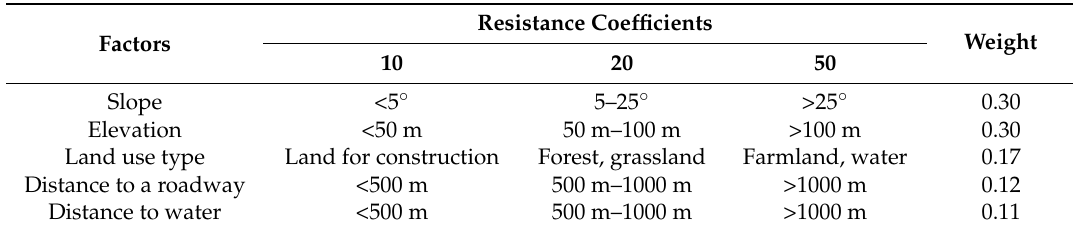
Table 5. Resistance coefficients and weights of resistance factors for urban expansion.